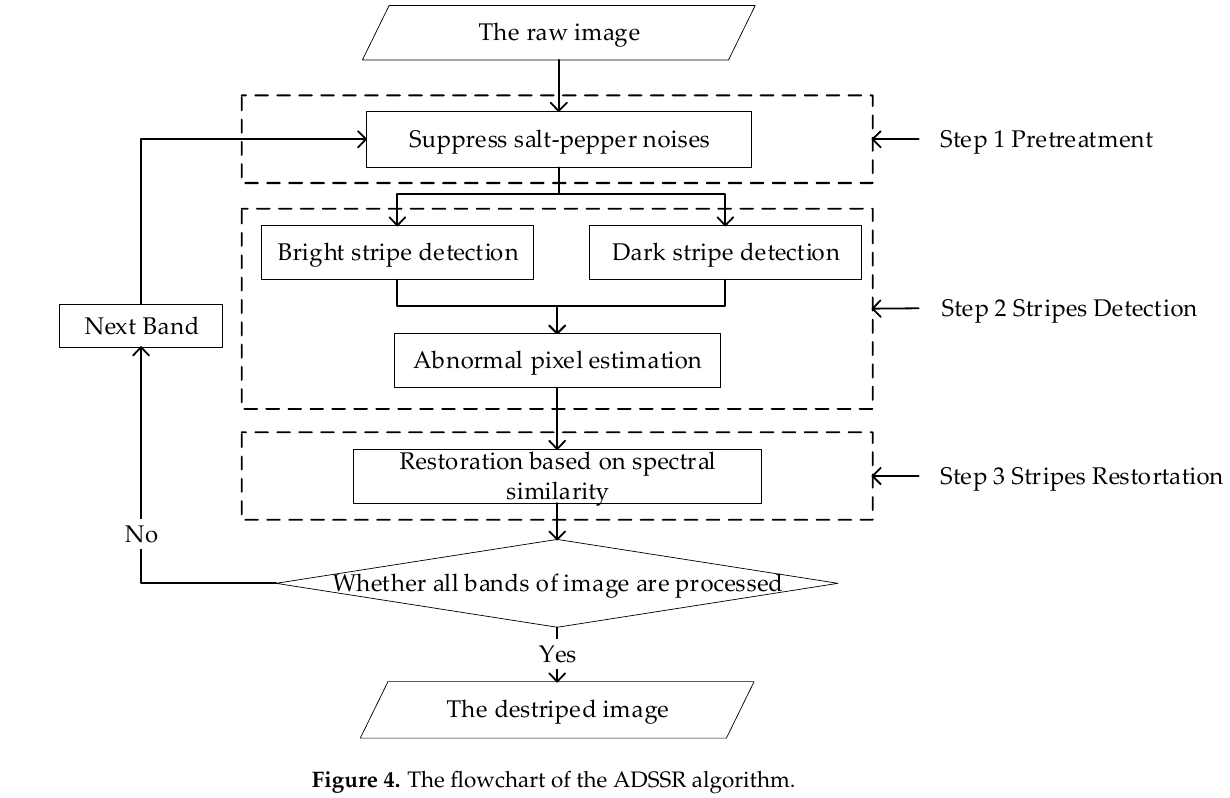
Figure 4. The flowchart of the ADSSR algorithm.